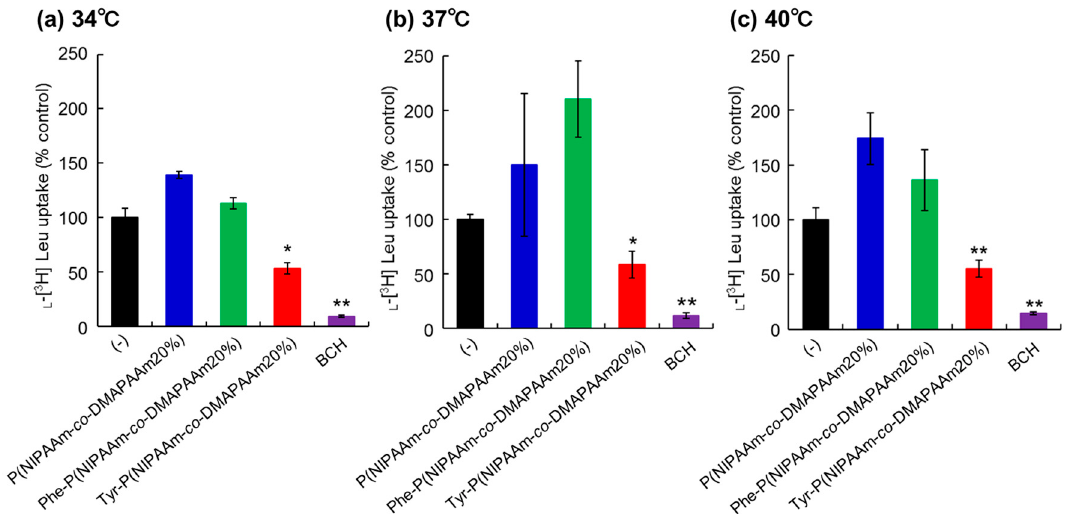
Figure 3. Inhibition of L -[ 3 H]-leucine uptake in HeLa cells at ( a ) 34 ◦ C; ( b ) 37 ◦ C and ( c ) 40 ◦ C. The concentration of inhibitors P(NIPAAm- co -DMAAm20%, Phe-P(NIPAAm- co -DMAAm20%), and Tyr-P(NIPAAm- co -DMAAm20%), and system L specific inhibitor, BCH was 2 mM. * p < 0.05, ** p < 0.01 vs. control ( n = 3).